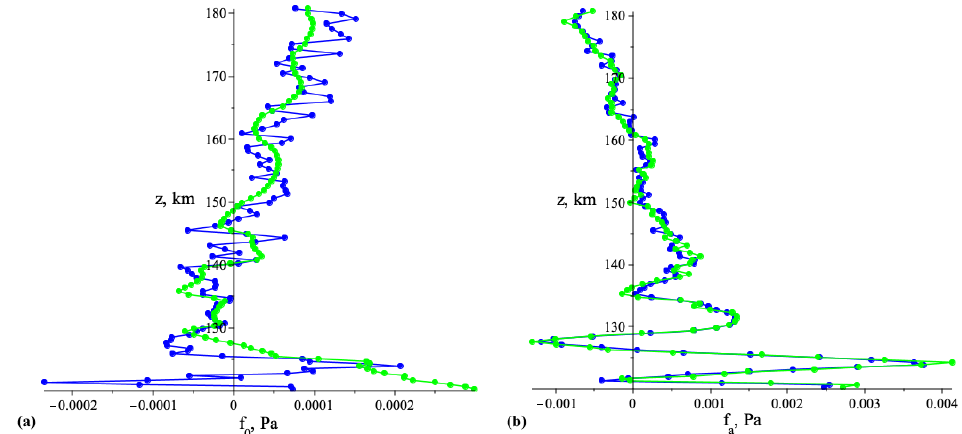
Figure 3. Comparison of the functions f 0 ( z ) ( a ) and f a ( z ) ( b ) obtained using the formulas (41), (43) (49) and (50), respectively, for the cases of standard atmosphere H ( z ) (25) (in blue) and linear height scale dependence H ( z ) model (27) (in green).